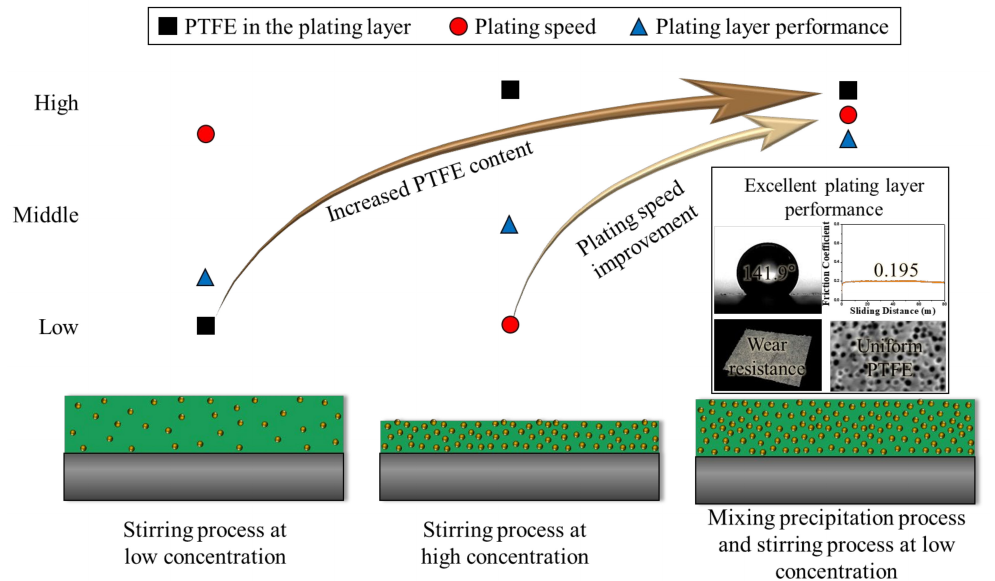
Figure 8. Effect of combined precipitation and stirring process at low PTFE concentration compared to the result of plating using only